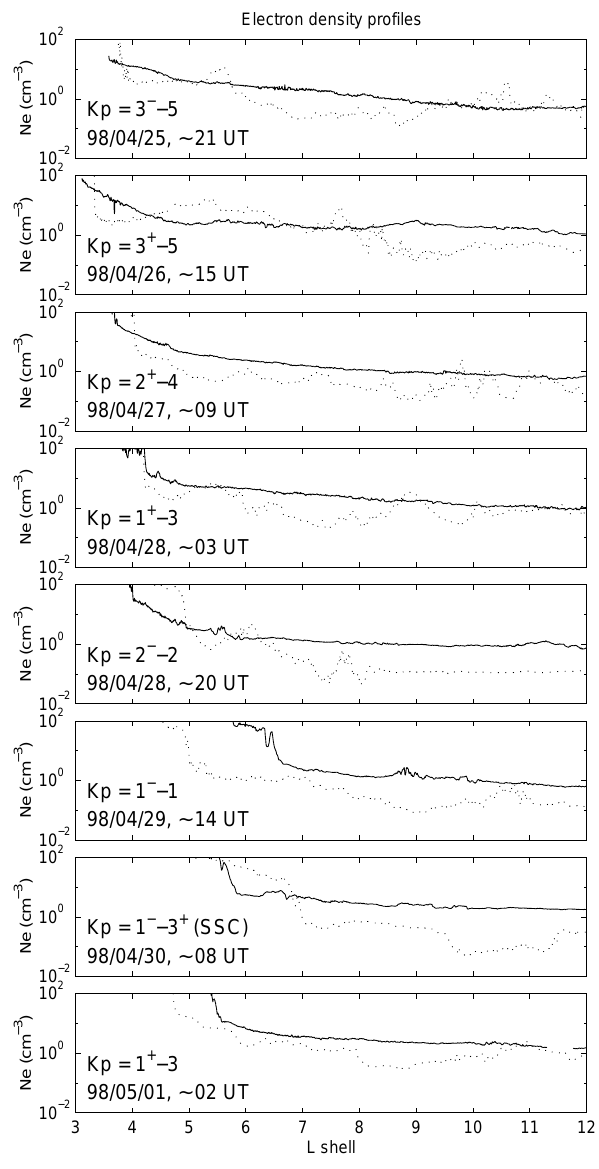
Fig. 6. Electron density plotted against L-shell for midnight (dotted lines) and noon (solid lines); the date and UT time refers to the nightside observations, the dayside data are taken 3–4h